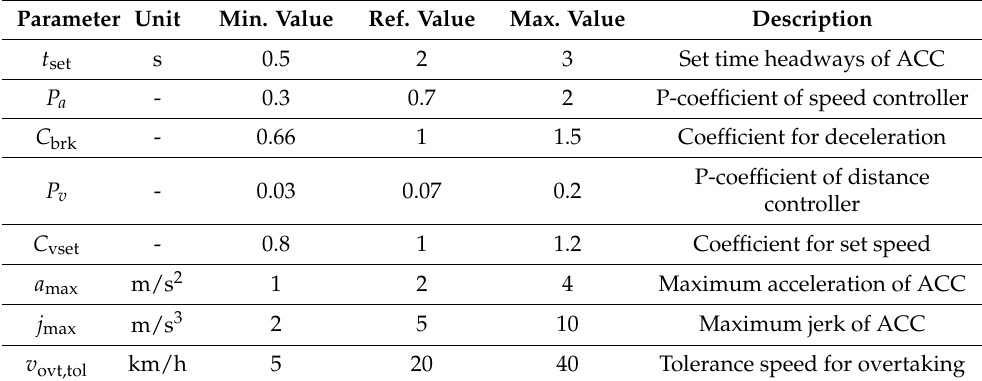
Table 3. AV setting parameters.